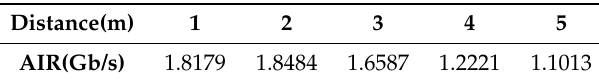
Figure 9. The AIR at each point. ( a ) The AIR is interpolated with a linear function. ( b ) The AIR is interpolated with a linear function between 1 m and 3 m, and a nonlinear function between 3 m and 5 m. Table 4. The AIR at each calibration